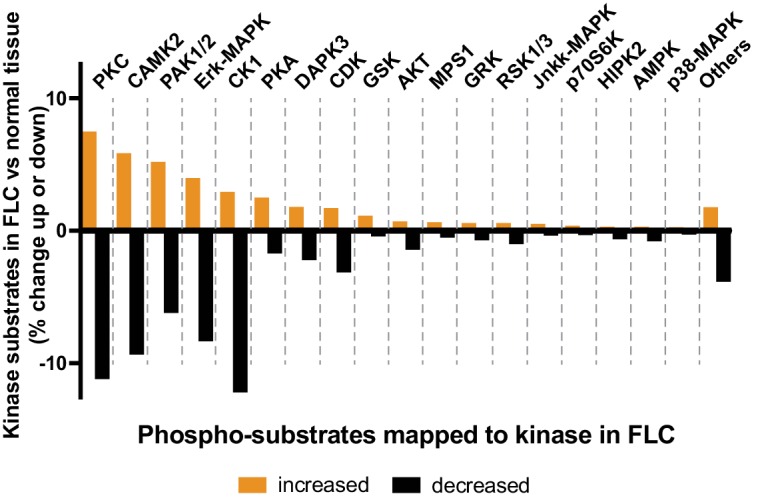
Kinase network rewiring in FLC.Phospho-substrate analysis of phosphoproteomic data from FLCs showing a spectrum of kinases implicated in covalent modification of heterogeneous tumor tissue. Putative kinase substrates were classified using NetworKIN as described in Figure 1 and Materials adn methods. Bar graph depicts the percent change of kinase substrates elevated (orange) and attenuated (black) in FLC.